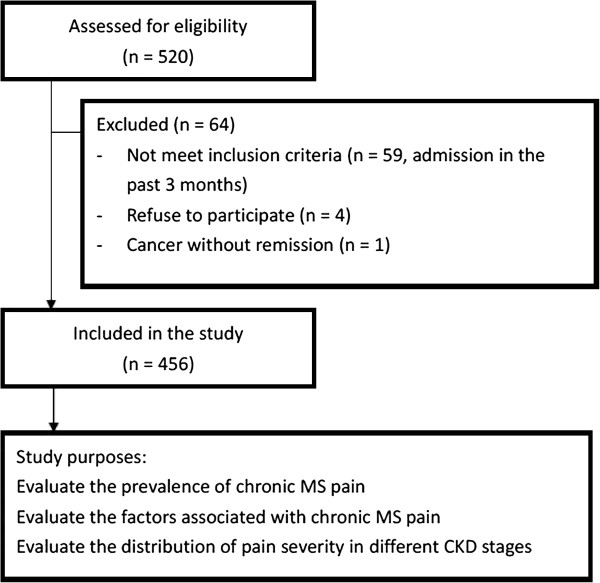
Flow chart indicates patient enrolment.